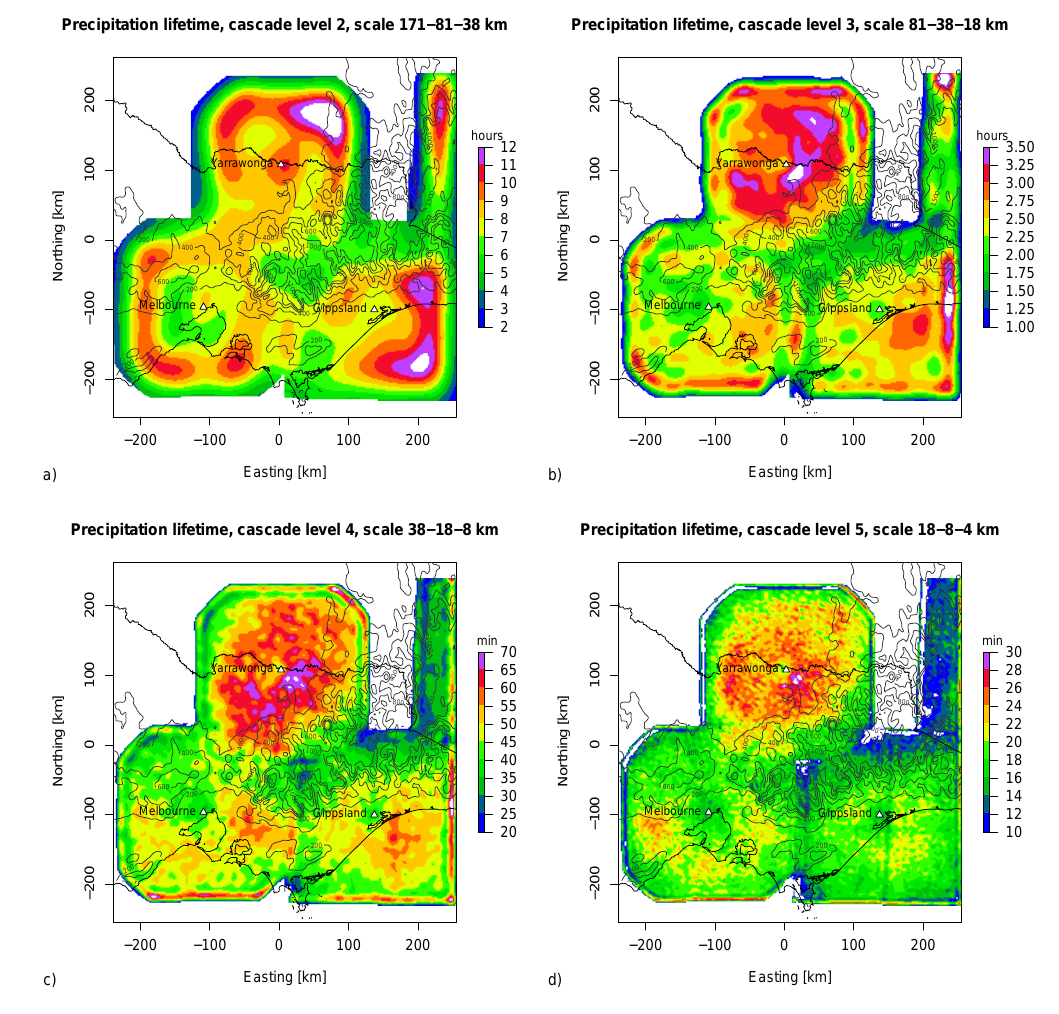
Figure 3. Spatial distribution of the precipitation lifetimes for the four middle cascade levels. (a) 171- 81 -38km, (b) 81- 38 -18 km, (c) 38- 18 -8 and (d) 18- 8 -4km. White tones are used for regions outside the radar domain or presenting values that exceed the range of the color